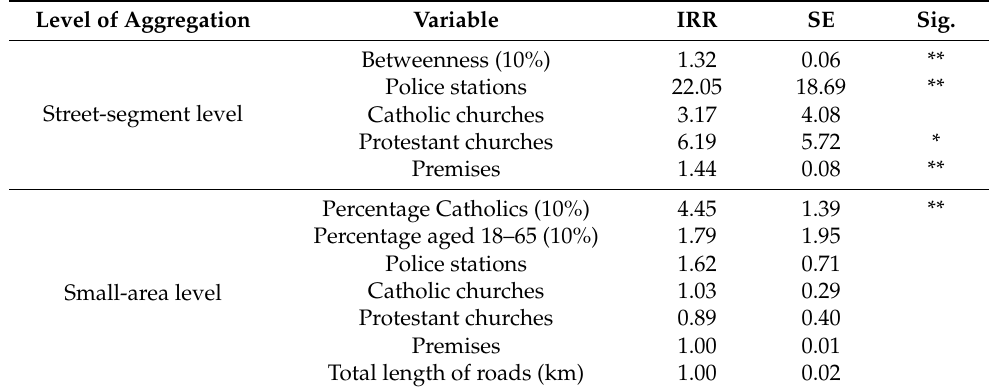
Table 2. Estimates from an OLRE Poisson regression of the location of violent dissident Republican incidents. Level of Aggregation Variable IRR SE Sig.